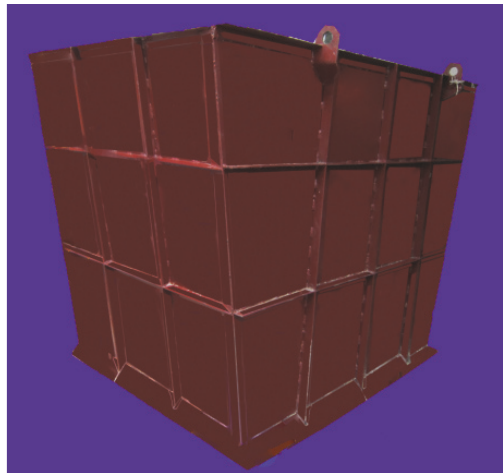
Figure 1: Overview of the steel water tank designed for the dynamic